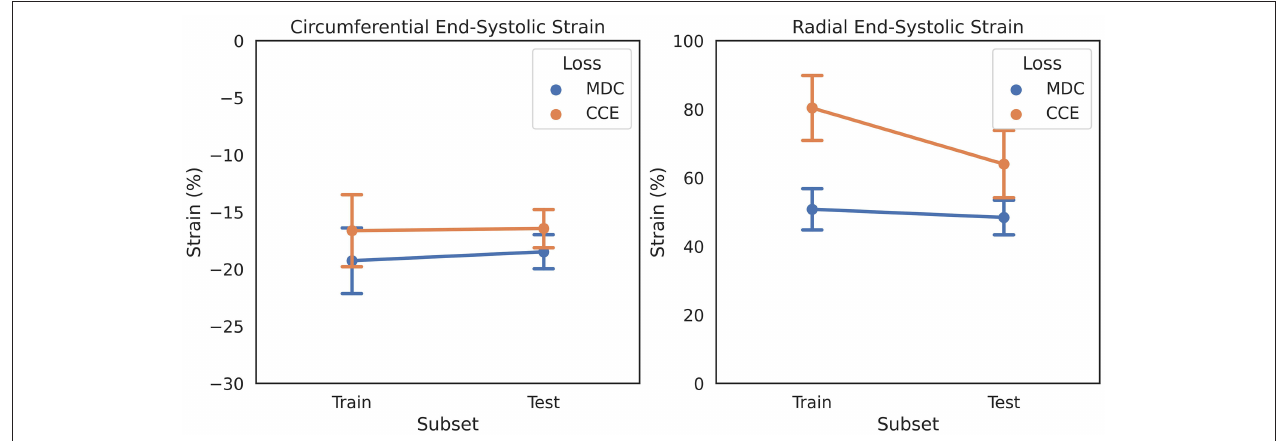
FIGURE 2 | Effect of anatomical regularization of motion estimates on strain on the ADCD dataset. Regularization with multiclass dice coefficient (MDC) and categorical crossentropy (CCE) functions result in different strain values in healthy subjects, shown as mean and standard deviation.